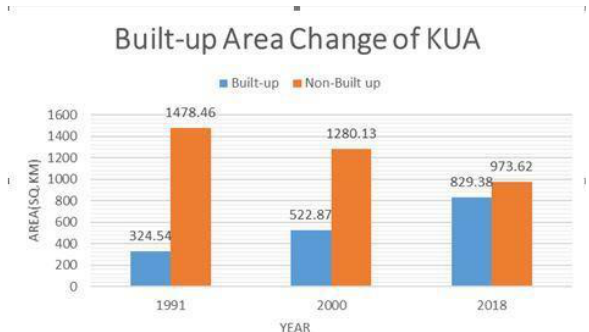
Figure 5: Change in the areal extent of built-up and non-built- up classes for 1991, 2000 and 2018.